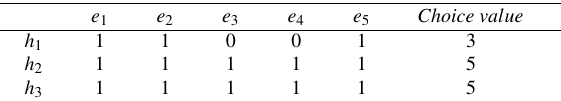
Table 7: Tabular representation of L (( F , A ) , 0 . 35 ) with choice